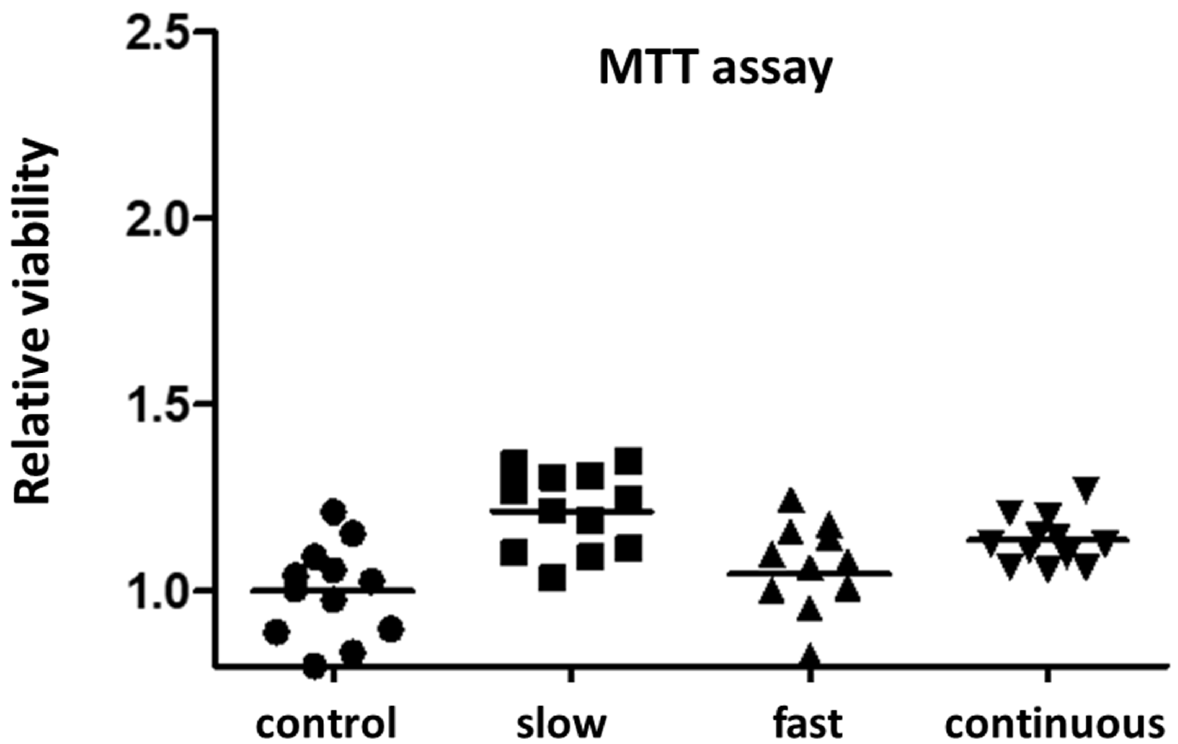
Figure 3. Relative viability of INS-1 cells treated with Tac concentrations using different incubation profiles related to a control of cultured INS-1 cells exposed to standard medium without Tac.